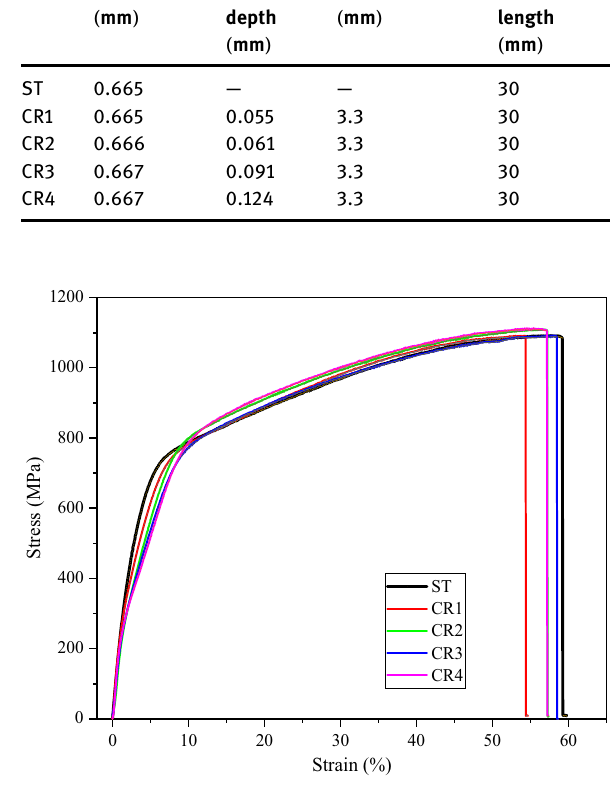
Figure 2: Monotonic tensile behavior of fi